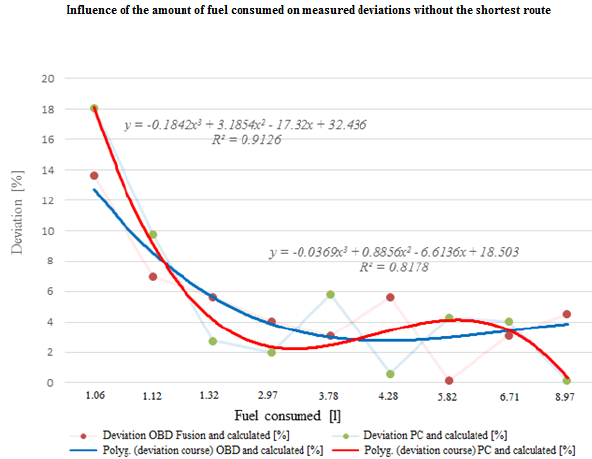
Figure 7: Influence of the amount of fuel consumed on measured deviations without taking into account the shortest route – PC